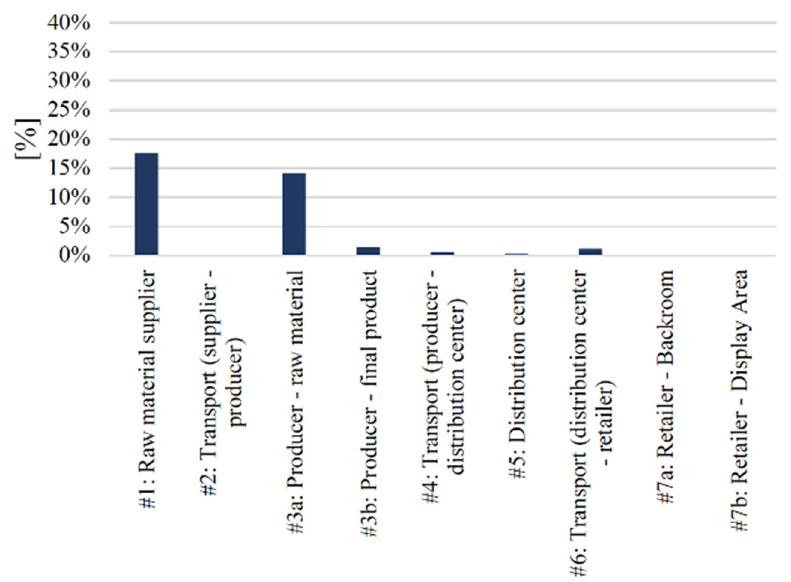
Figure 4. Quality losses at each actor of the cold chain.